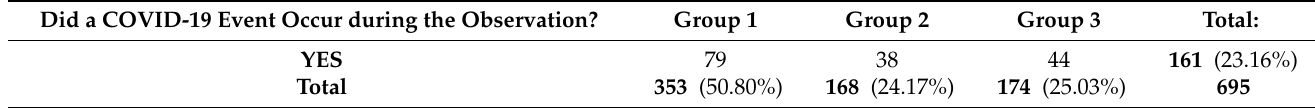
Table 8. Comparison of the number of COVID-19 related events by treatment group.